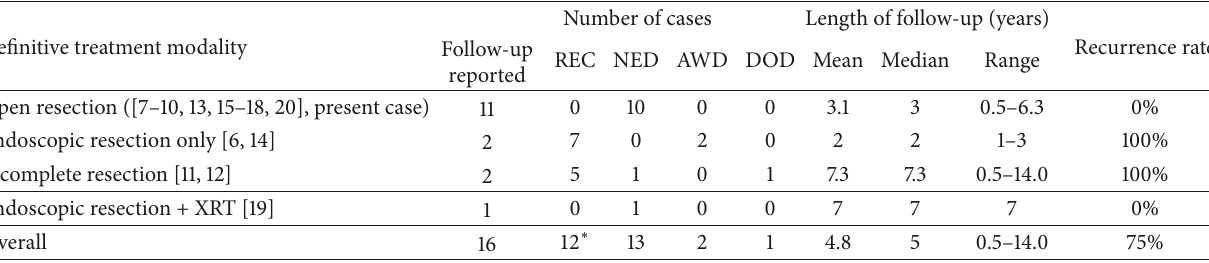
Table 3: Patient recurrence rates with regard to treatment modality